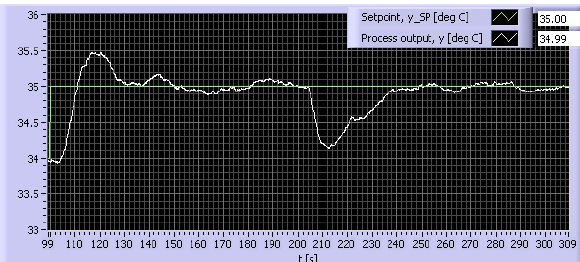
Figure 6: Skogestad’s method: Responses with loop gain increase of 2.4.